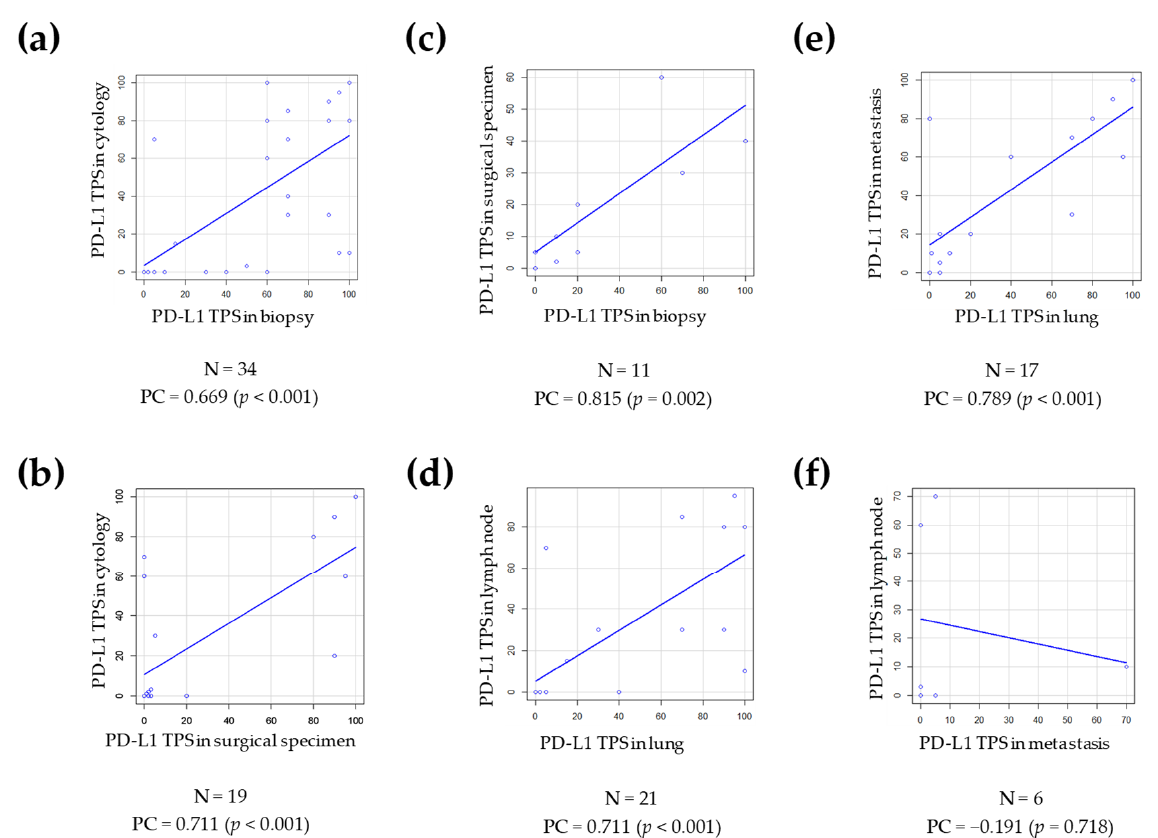
Figure 4. Scatter plots comparing PD-L1 TPS of paired cases with the respective Pearson’s correlation coefficient. Cases with different type of sample: ( a ) cytology and biopsy; ( b ) cytology and surgical specimen; and ( c ) surgical specimen and biopsy. Comparison of samples from different sites: ( d ) primary lung tumor and lymph node metastasis; ( e ) primary lung tumor and distant metastasis; and ( f ) lymph node and distant metastasis. Abbreviations: N, number of cases; PC, Pearson’s correlation coefficient; PD-L1, programmed cell death ligand 1; TPS, tumor proportion